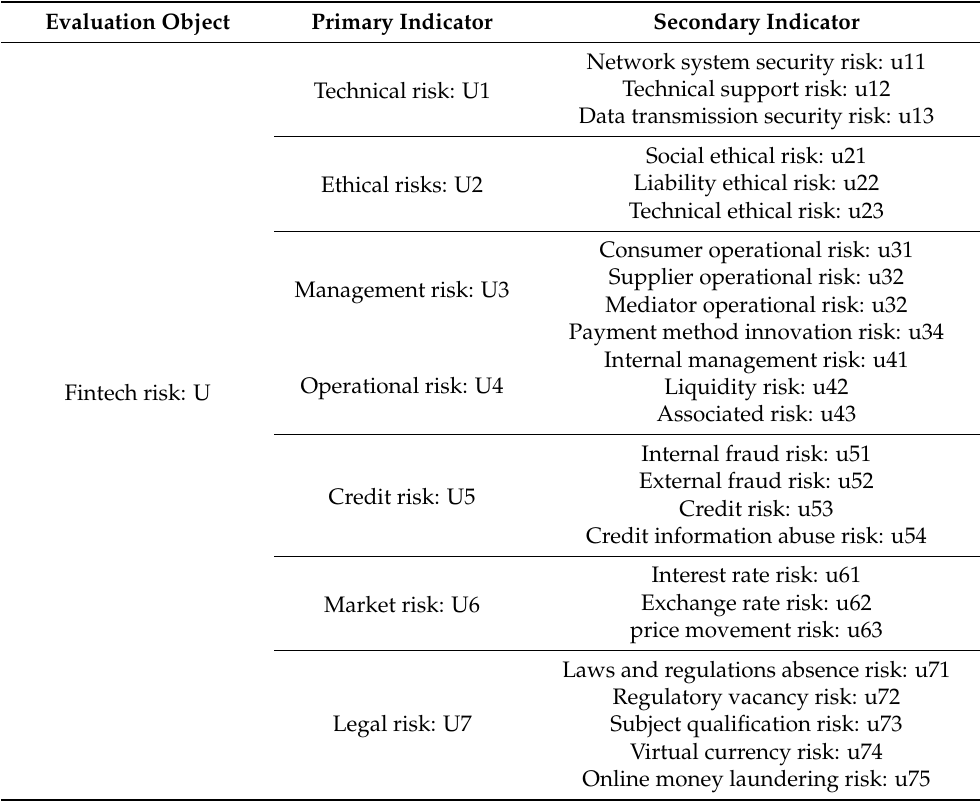
Table 1. Fintech Risk Assessment System.